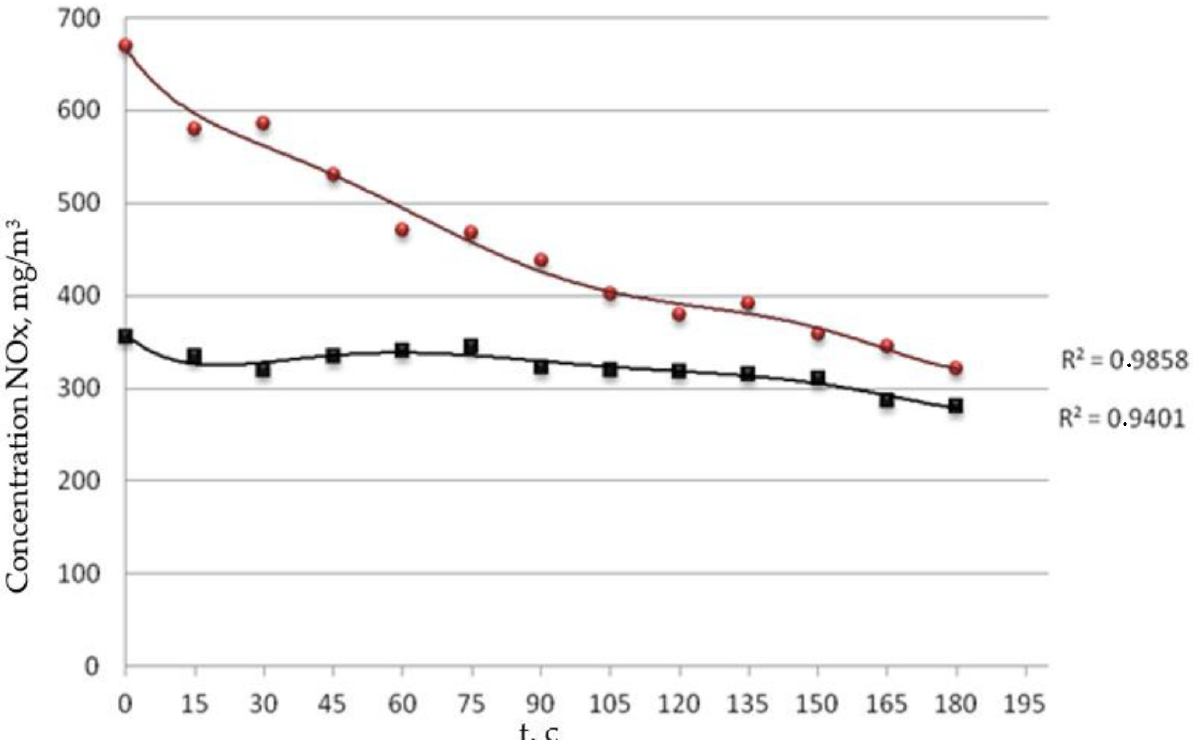
Figure 6. The dependence of the concentration of nitrogen oxides in the explosion products in time (compiled by the author R.S. Babkin).